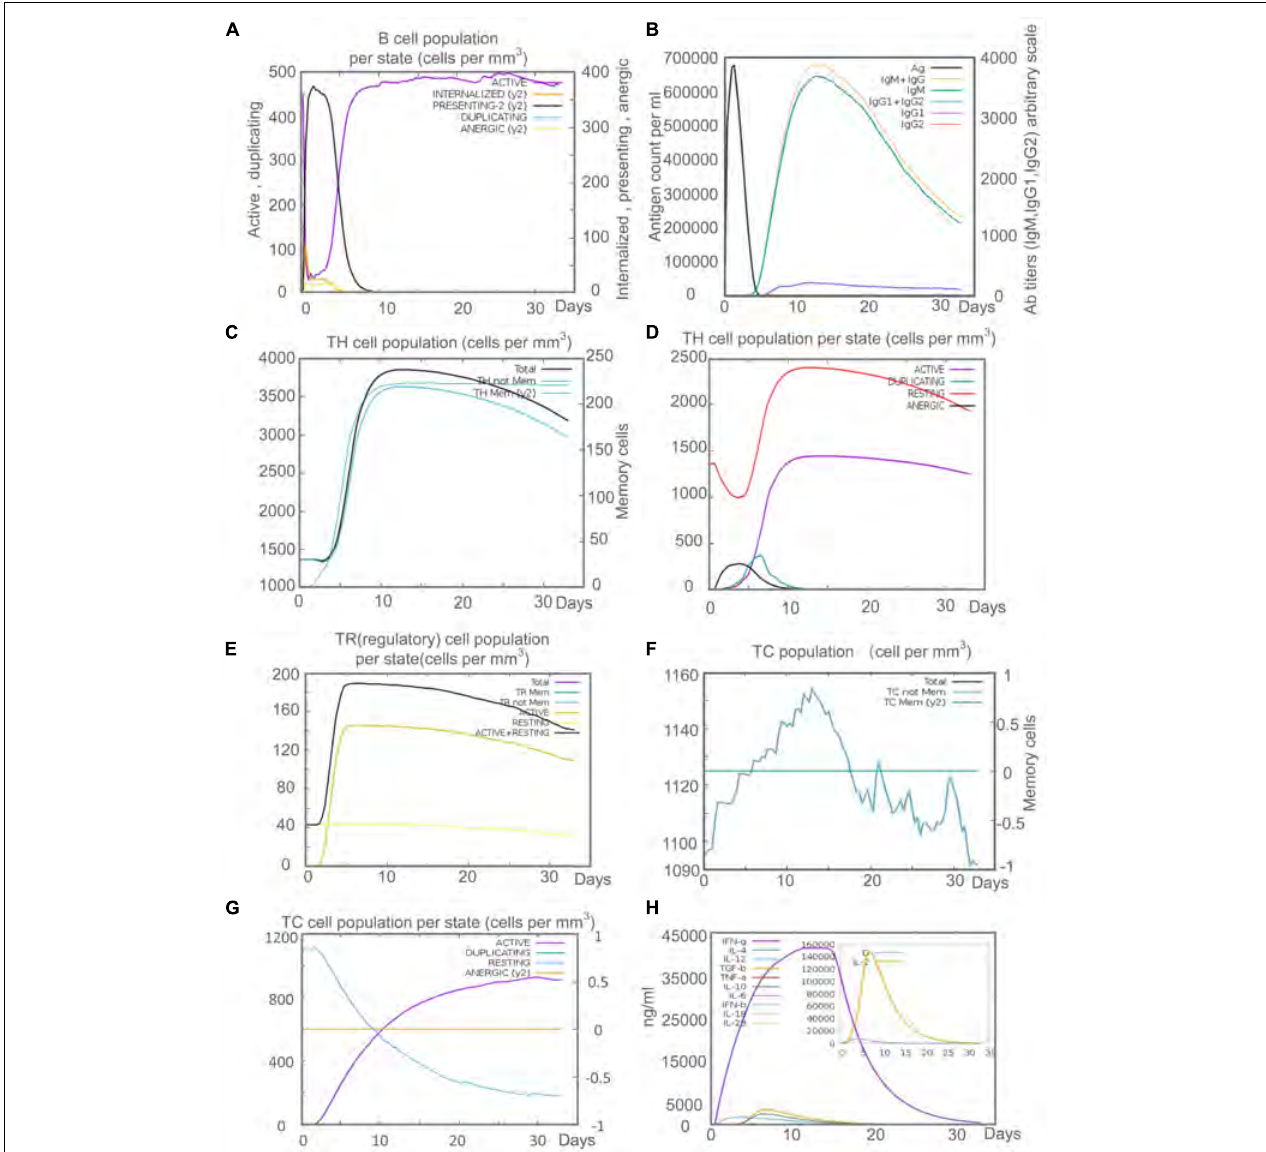
FIGURE 10 | The adaptive immune responses induced by C543P in C-ImmSim server. (A) Active B cell (purple) secretion after antigen stimulation. (B) The primary B cell antibody produced after antigen stimulation is IgM + IgG (yellow) changes over time. (C,D) Changes in the secretion level of helper T lymphocytes and the secretion levels of helper T lymphocytes of different memory types. (E) Changes in Treg T cell secretion after antigen stimulation. (F,G) Changes in the level of CD8 + T secretion after antigen stimulation and the secretion of different types of CD8 + T cells. (H) . Changes in secretion levels of cytokines, mainly IFN- γ (purple) and IL-2